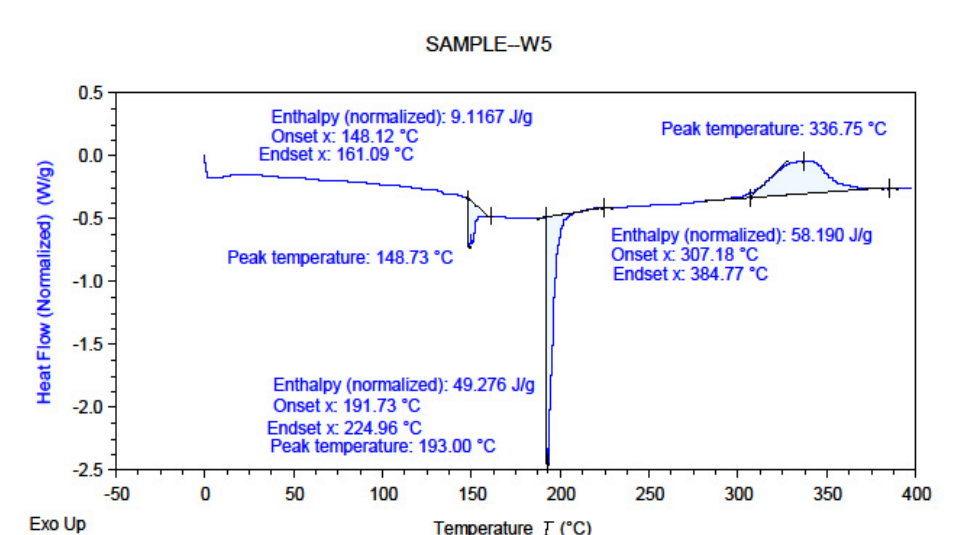
Fig. 7. Differential Scanning Calorimetry (DSC) of